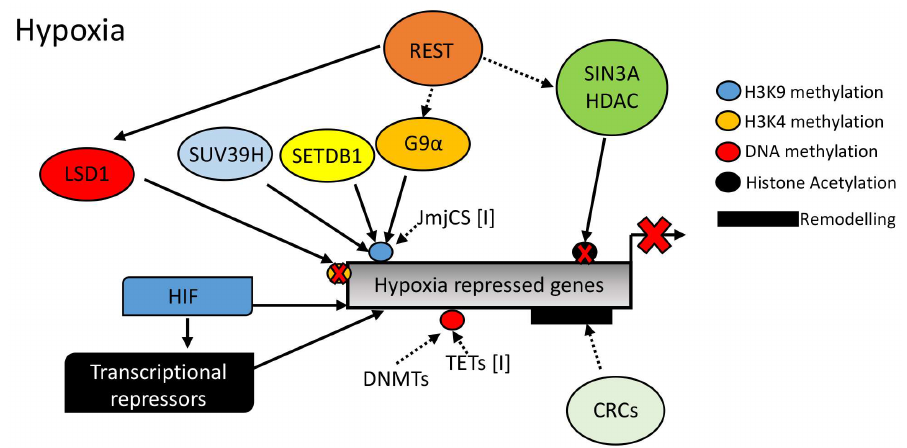
Figure 4. Mechanisms of hypoxic gene repression in the context of chromatin structure. Hypoxia Inducible Factor (HIF), Repressor Element 1-Silencing Transcription Factor (REST), SIN3 Transcription Regulator Family Member A (SIN3A), Histone Deacetylase, (HDAC), G9α Like Protein 1 (GPL), Suppressor of Variegation 3–9 Homolog (SUV39H), SET Domain Bifurcated 1 (SETDB1), Chromatin Remodeller Complex (CRC), Jumoni C (JmjC), DNA Methyl Transferase (DNMT), Ten-Eleven-Translocation (TET), and Lysine Specific Demethylase 1 (LSD1).